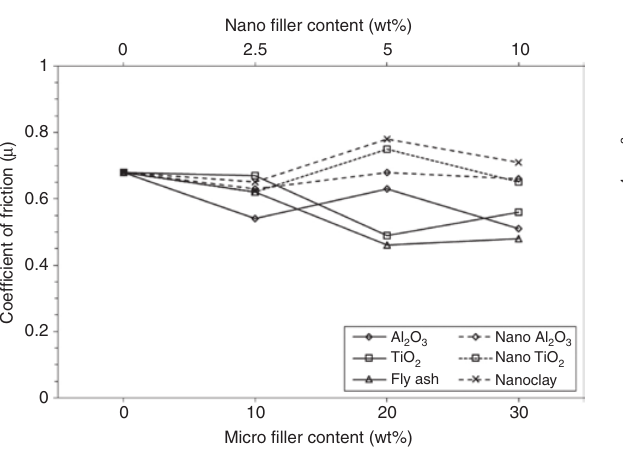
Figure 4: The variation of temperature of nano-Al composites against the time at 0.4 m/s sliding